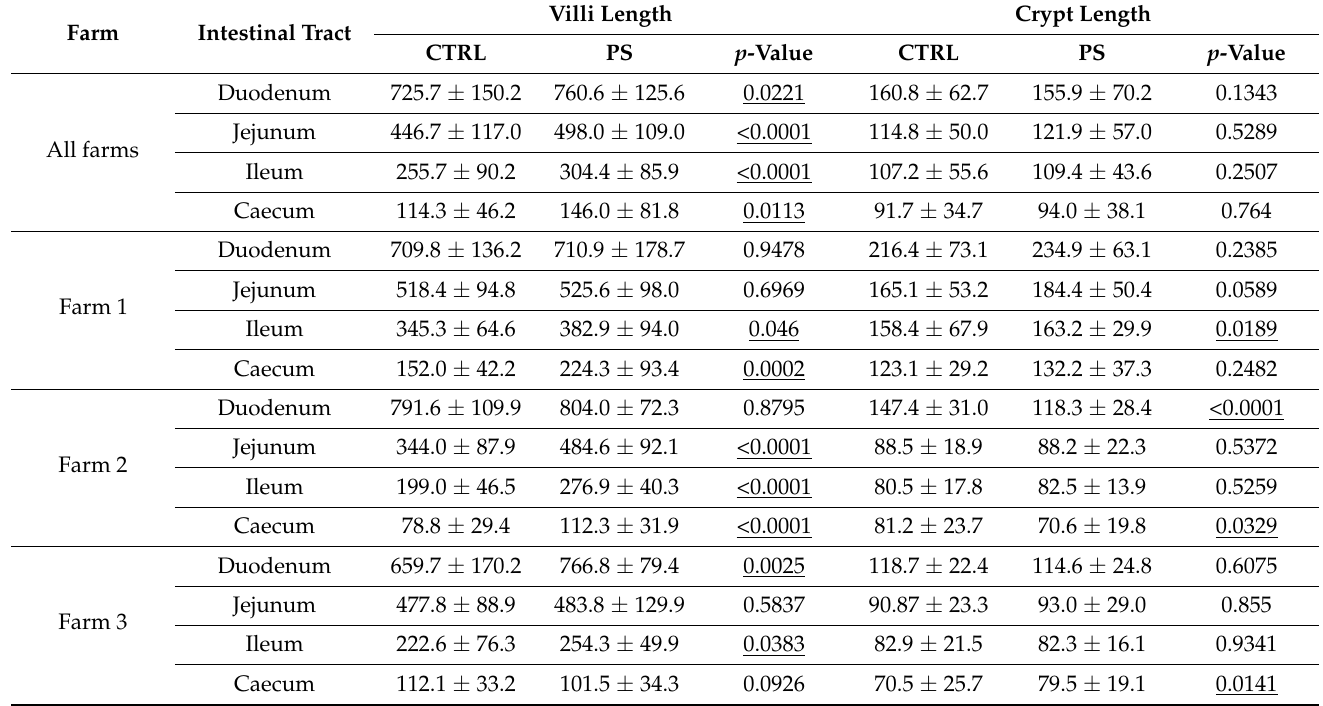
Table 2. Mean ± standard deviation of villi and crypts length (measured in µ m) in each intestinal tract of synbiotic-treated (PS) and control (CTRL) birds. p -values below 0.05, marking the statistical significance of a difference observed when comparing treatment and control groups across all farms or in each farm individually, are underlined.